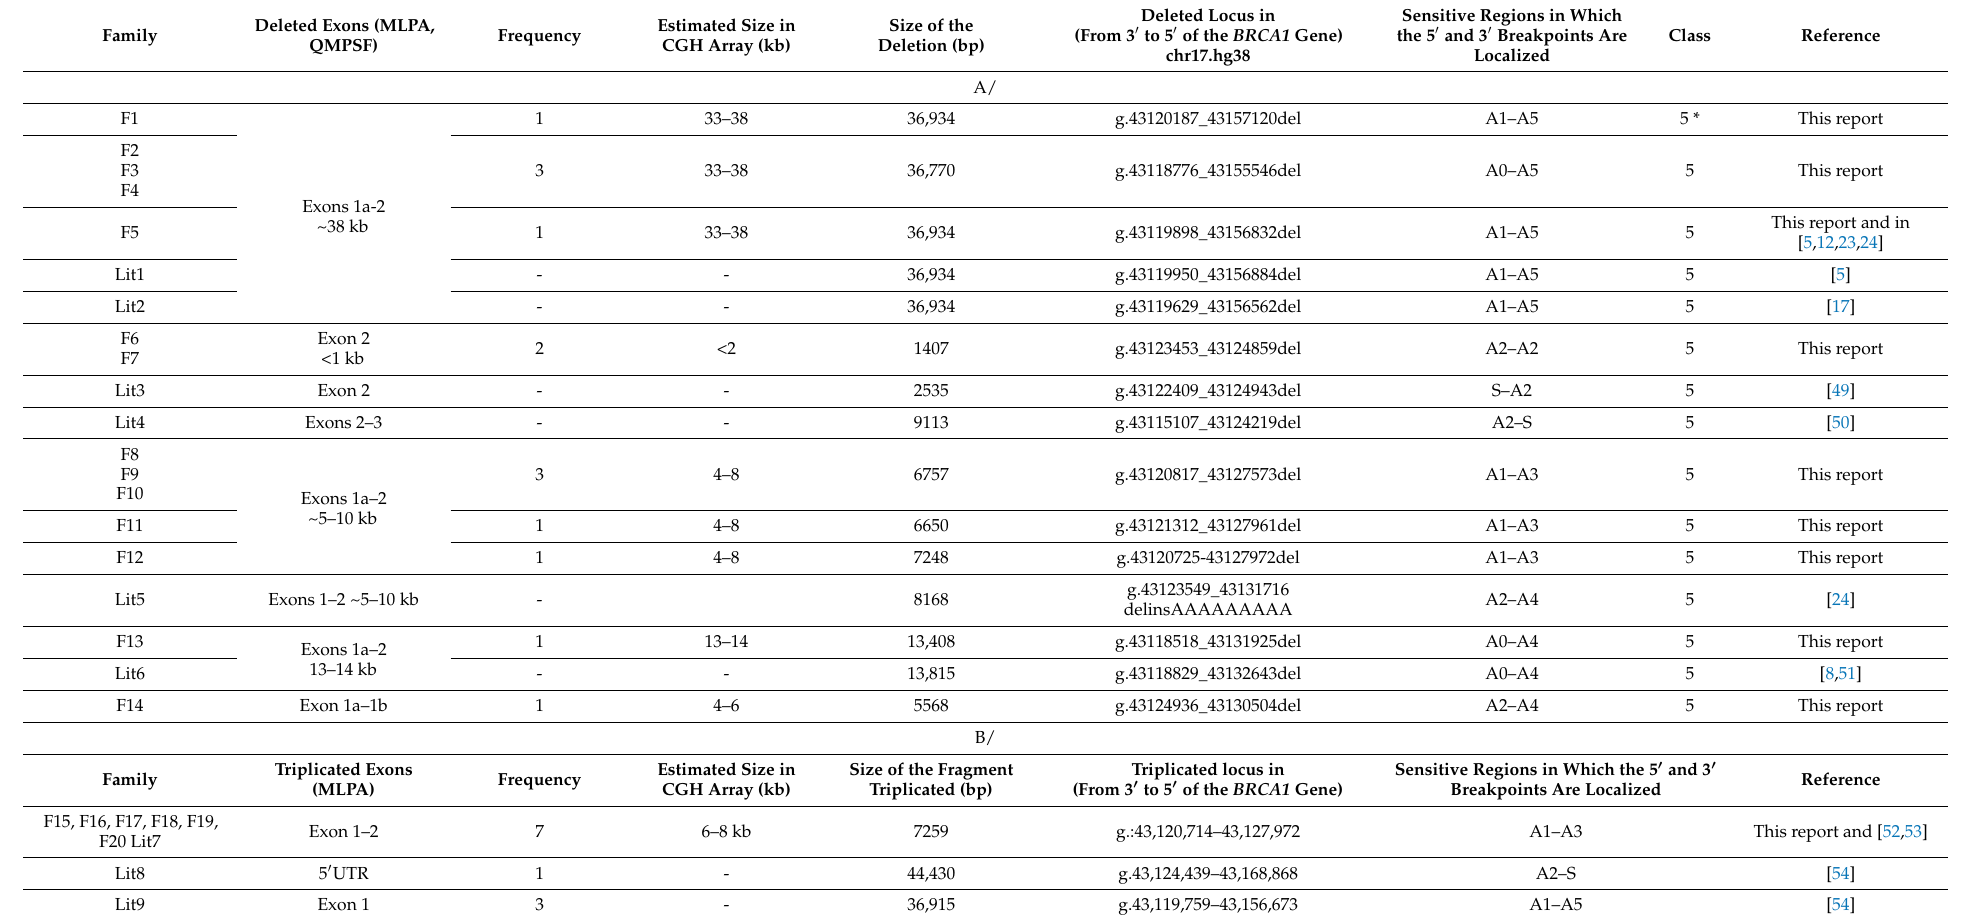
Table 2. Description and characterization of large genomic rearrangements involving the 5 (cid:48) region of the BRCA1 gene. A/ Families with deletion; B/ Families with triplication. A0, A2, A3, A4, A5: sensitive region with several breakpoints reported, S: breakpoint in the segmental duplication involving BRCA1 intron 2 and BRCA1 pseudogene, HS: breakpoint outside the segmental duplication, NE: not explored in this study. S: specific breaking point region; Lit: Family of literature. * Class 5 = pathogenic